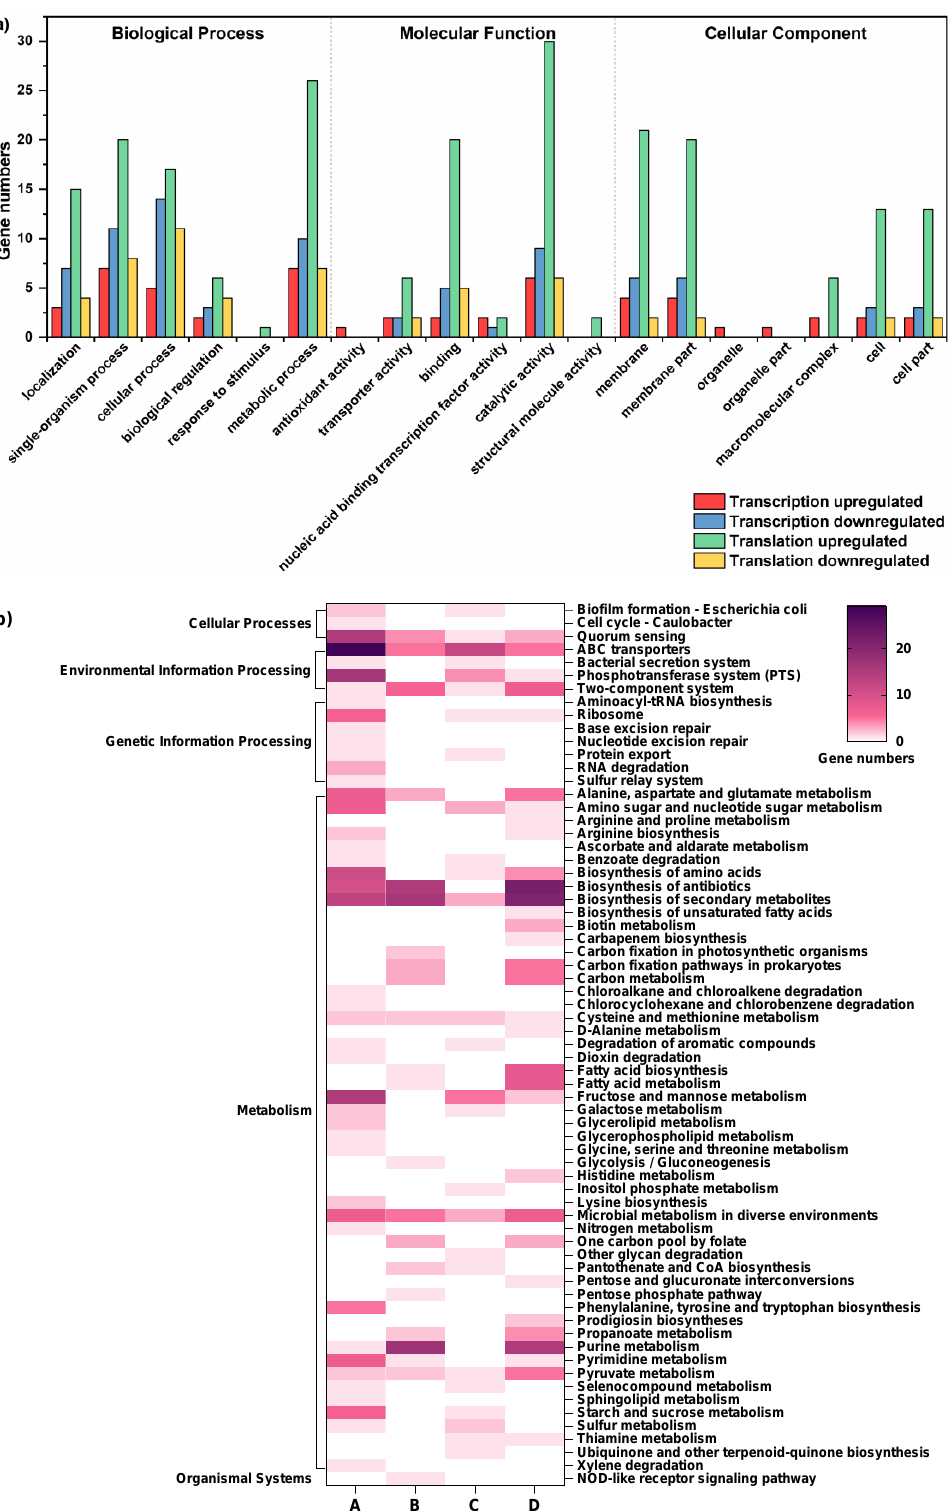
Figure 2. ( a ) GO analysis of DEGs in the AS and CG groups at the translational and transcriptional levels. ( b ) Significantly enriched KEGG pathways of DEGs in the AS and CG groups at the translational and transcriptional levels.